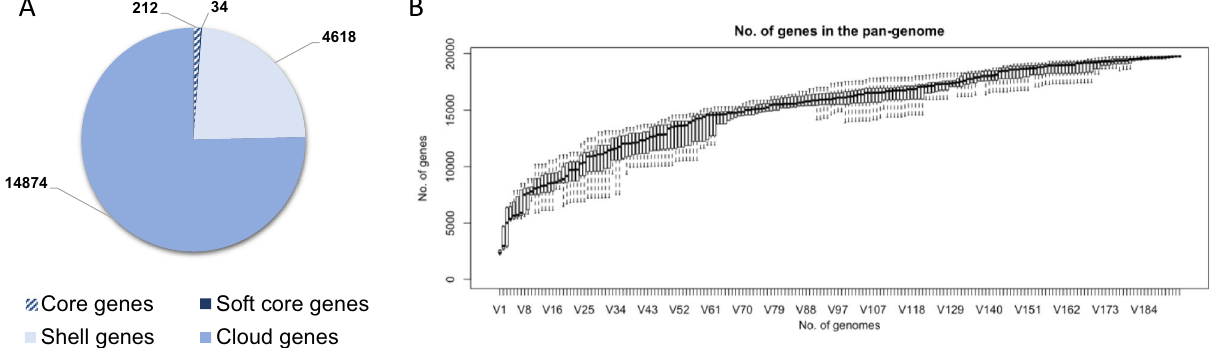
Figure 1. Comparative genomics analysis of the 193 Akkermansia sp. genomes. ( A ) Pangenome content. ( B ) New genes content variation as new genomes are added to the analysis.